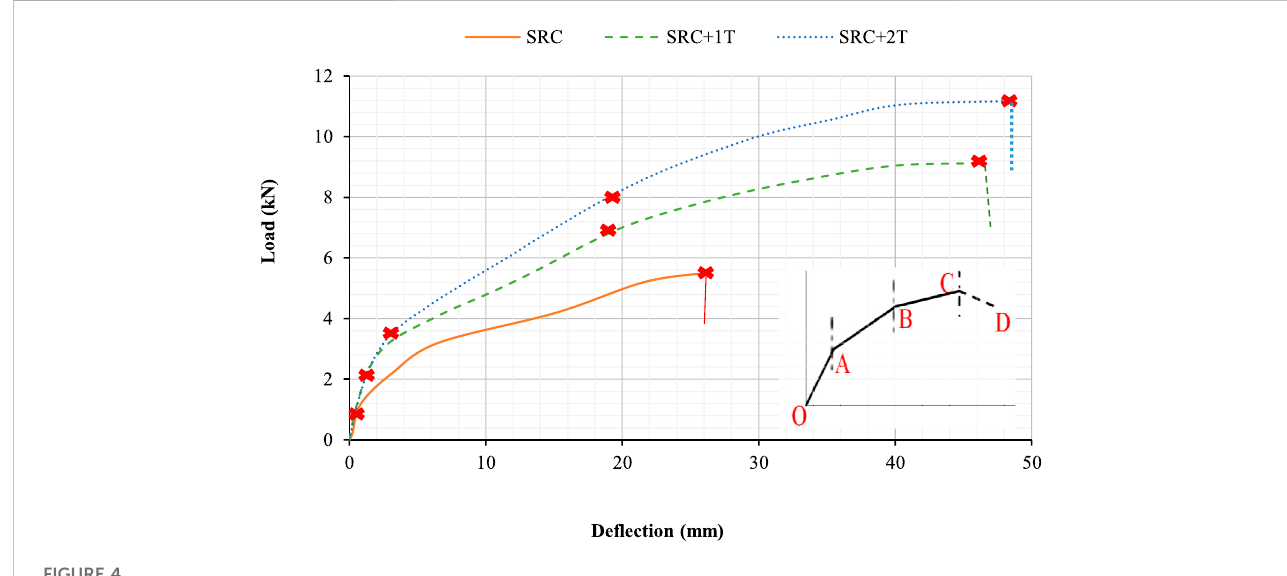
FIGURE 4 Comparison of load-de fl ection curve for the three slab